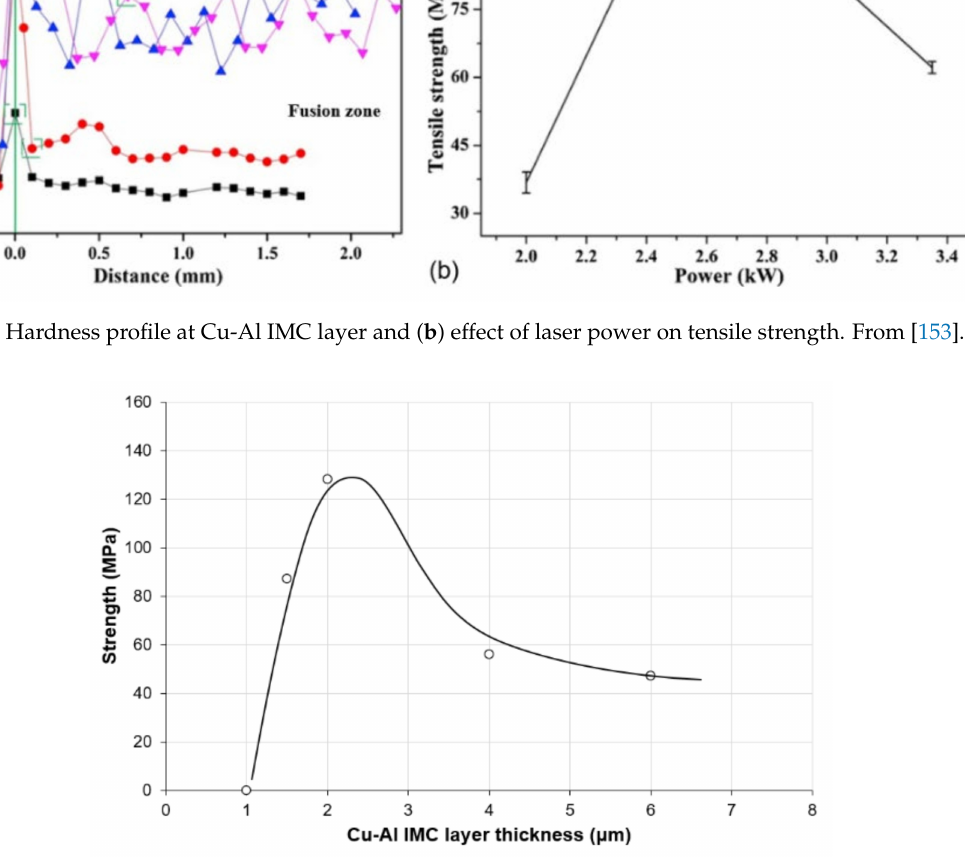
Figure 23. Effect of Cu-Al IMC layer thickness on strength. Based on